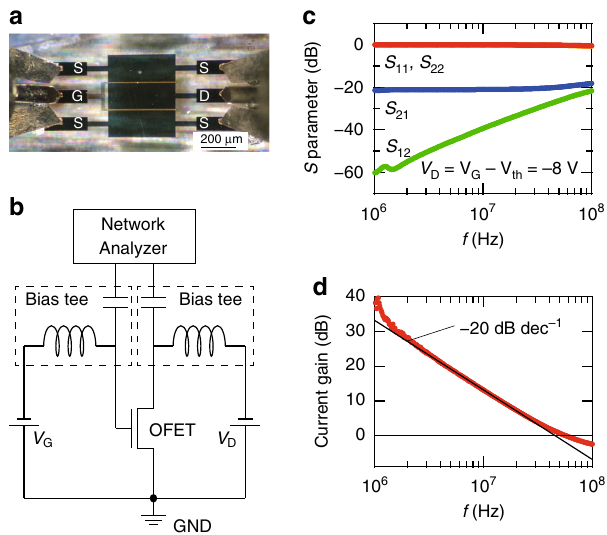
Fig. 3 Dynamic response evaluated by S -parameter measurements. a Top-view microscopy image of the dual-channel OFET used for the full (Fig. 2f, g). two-port scattering S -parameter measurements. b Schematic diagram of the full two-port scattering S -parameter measurements. c Dependence of the full S -parameters on frequency ( f ) for the OFET with L = 1.5 μ m and L = 1 μ m. The current gain as a function of f was evaluated from Eq. (5), as C described in the “ Methods ” section). d A typical example of the current gain as a function of f . f T is de fi ned as the frequency at which the current j ¼ 0, equivalently ∣ h ∣ = gain is zero (20log j h 21 21